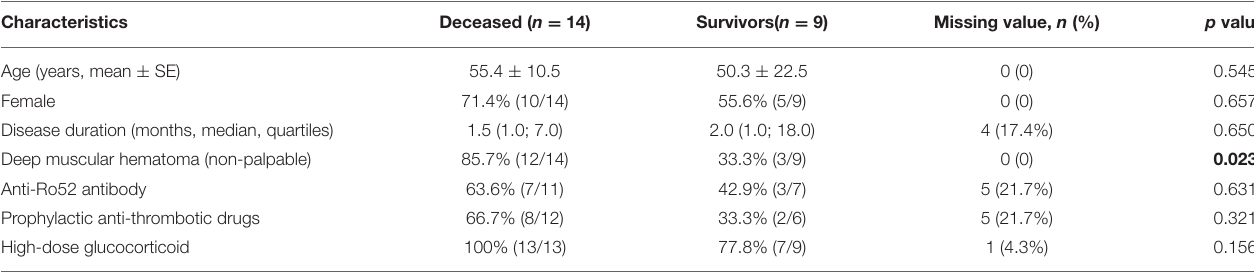
TABLE 2 | Comparisons of clinical characteristics and treatment data between the deceased and survivors in dermatomyositis complicated by spontaneous intramuscular hemorrhage.